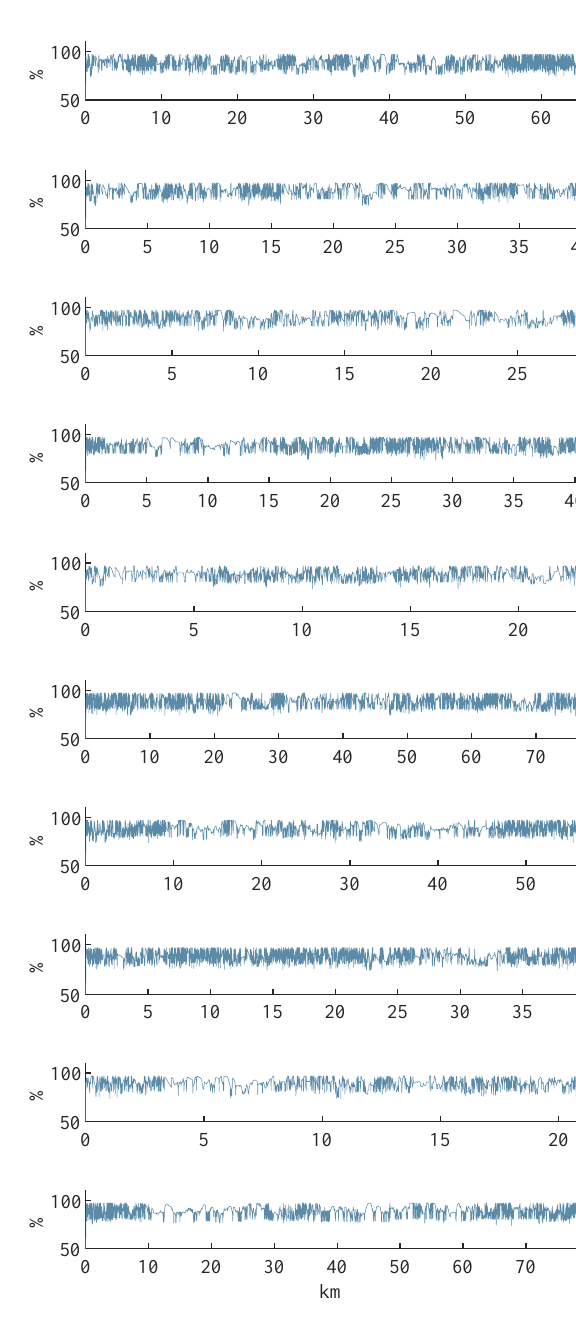
Figure A5. Electric powertrain efficiency with the cargo load on routes